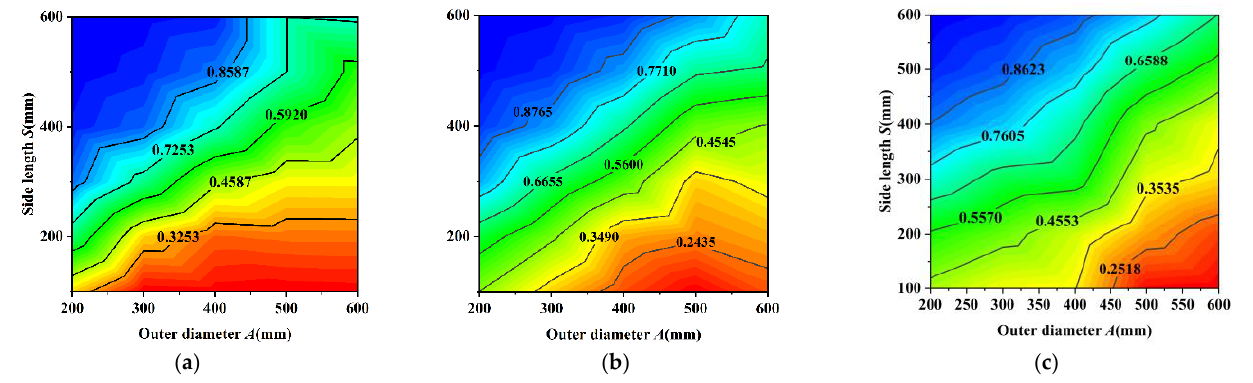
Figure 5. Variation of the uniformity coefficient α with A : ( a ) H = 100 mm; ( b ) H = 150 mm; ( c ) H = 200 mm.